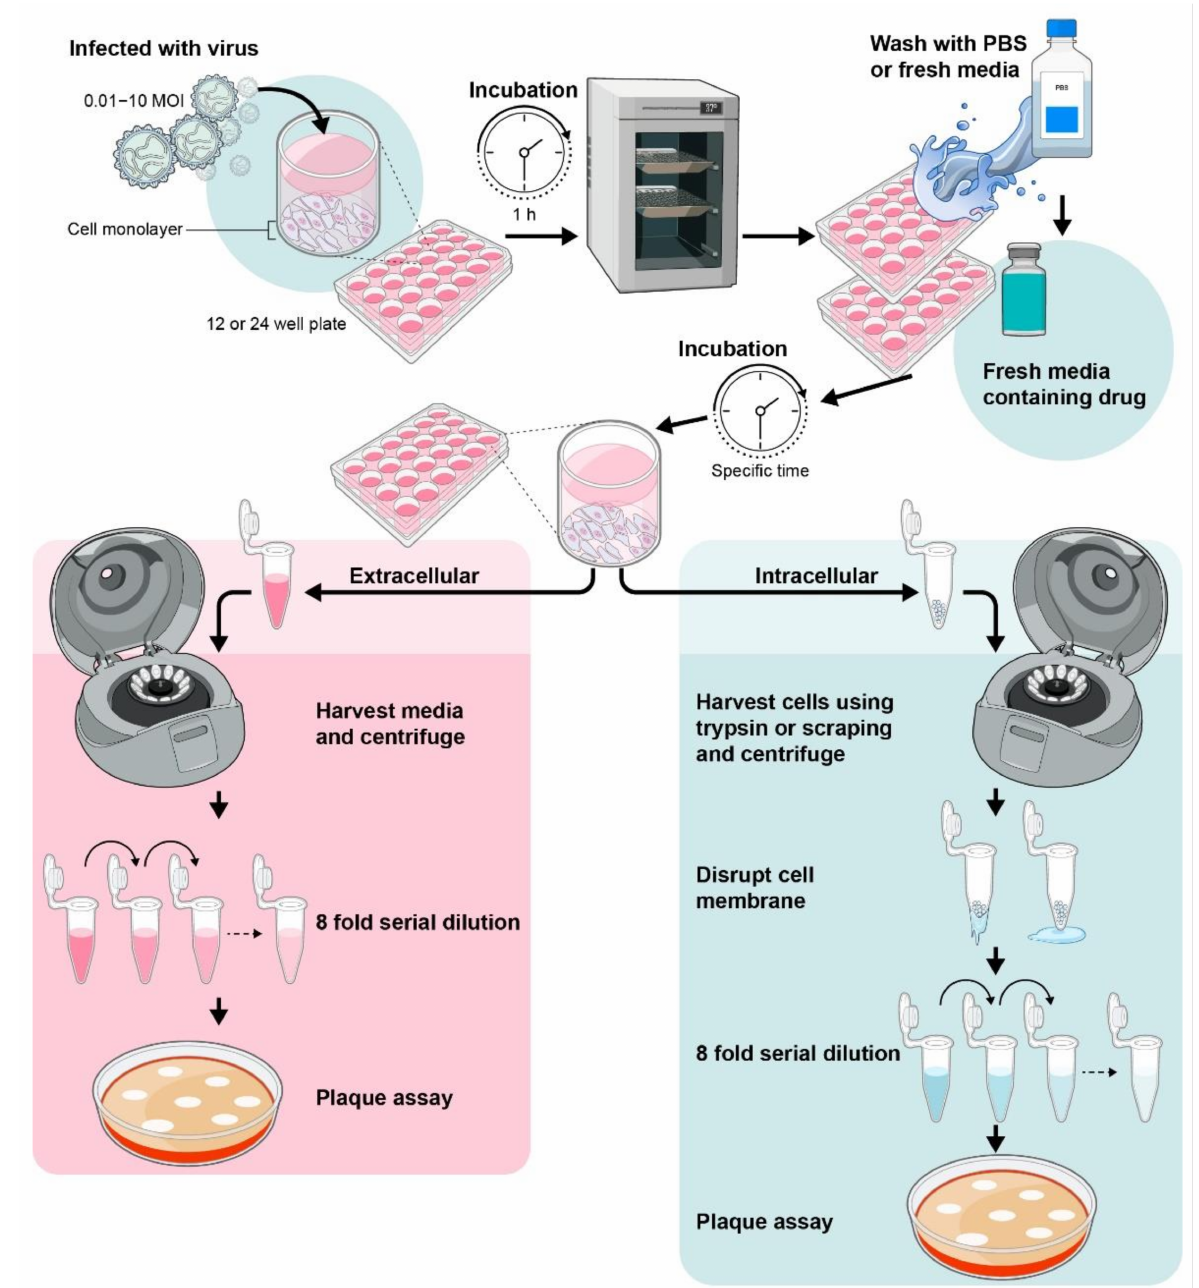
Figure 4. Schematic diagram of measuring antiviral efficacy using plaque assays. Assay protocol for intra-cellular or extra-cellular virus